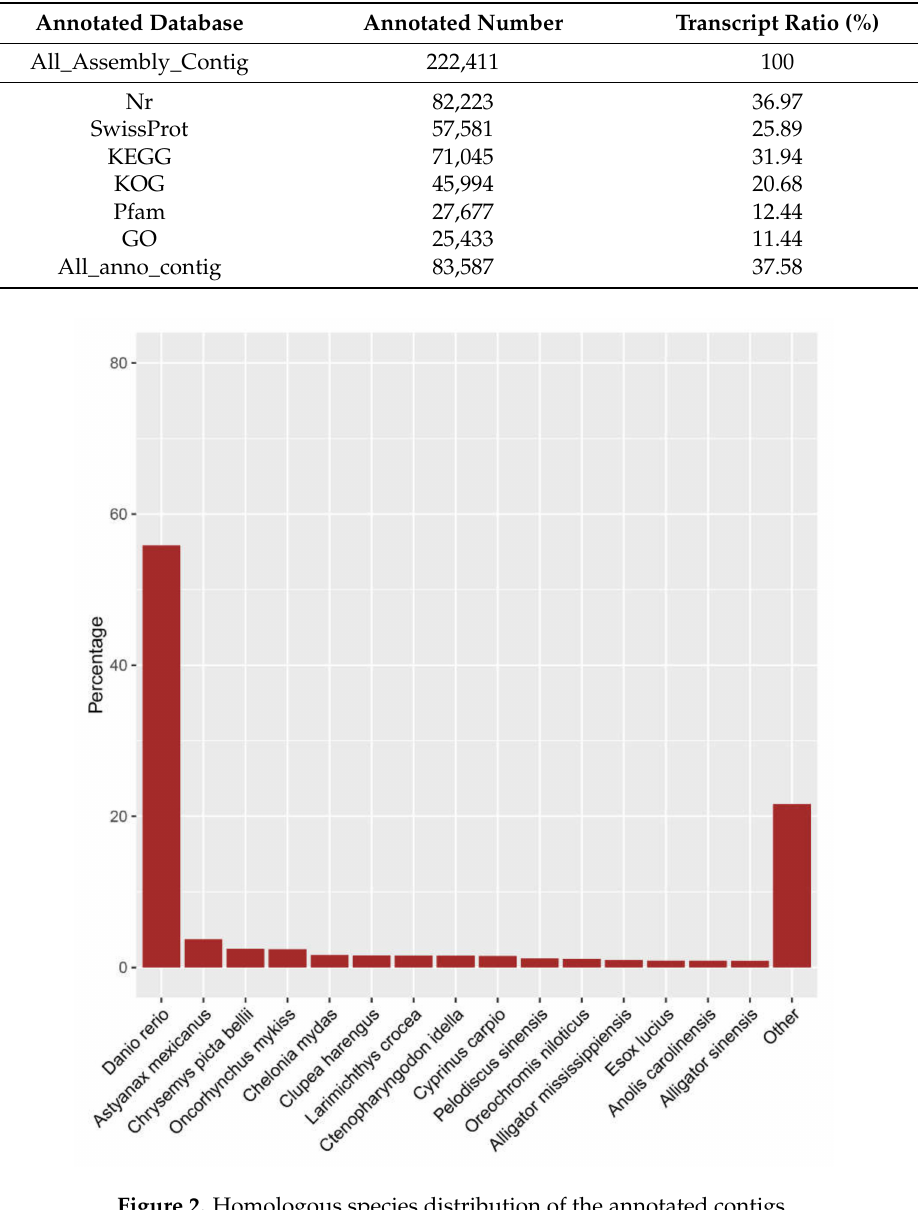
Figure 2. Homologous species distribution of the annotated